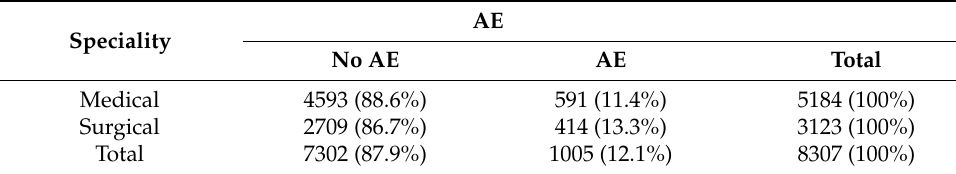
Table 1. Prevalence of AE in medical and surgical services.